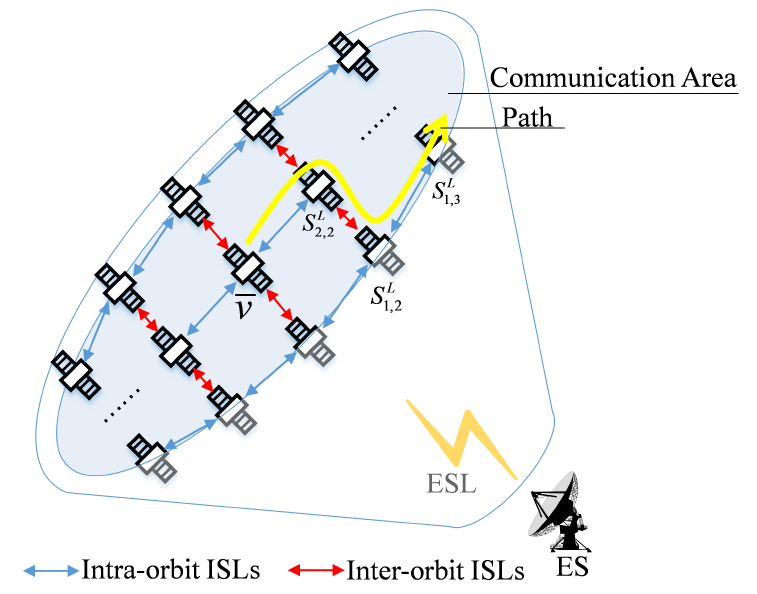
Figure 1. The first phase of Starlink.